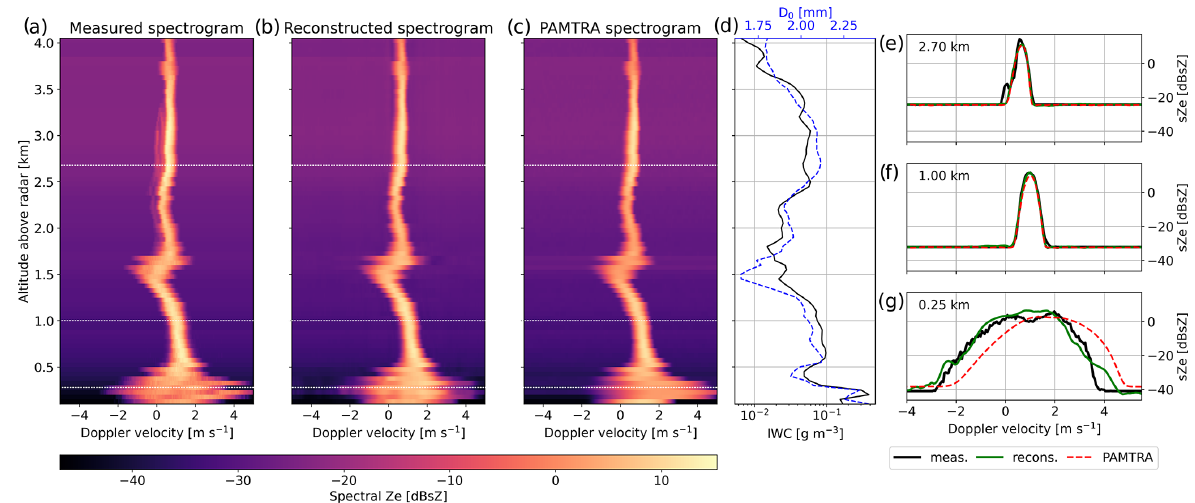
Figure 4. Examples of W-band spectrograms: (a) measured, (b) reconstructed through the pipeline, and (c) reconstructed in PAMTRA from the learned latent features. Corresponding spectra from selected altitudes are displayed in panels (e) , (f) , and (g) ; they are indicated with dashed white lines in the spectrograms. The reconstruction of X-band spectrograms (not shown) is of similar quality. (d) IWC and D 0 profiles retrieved from these